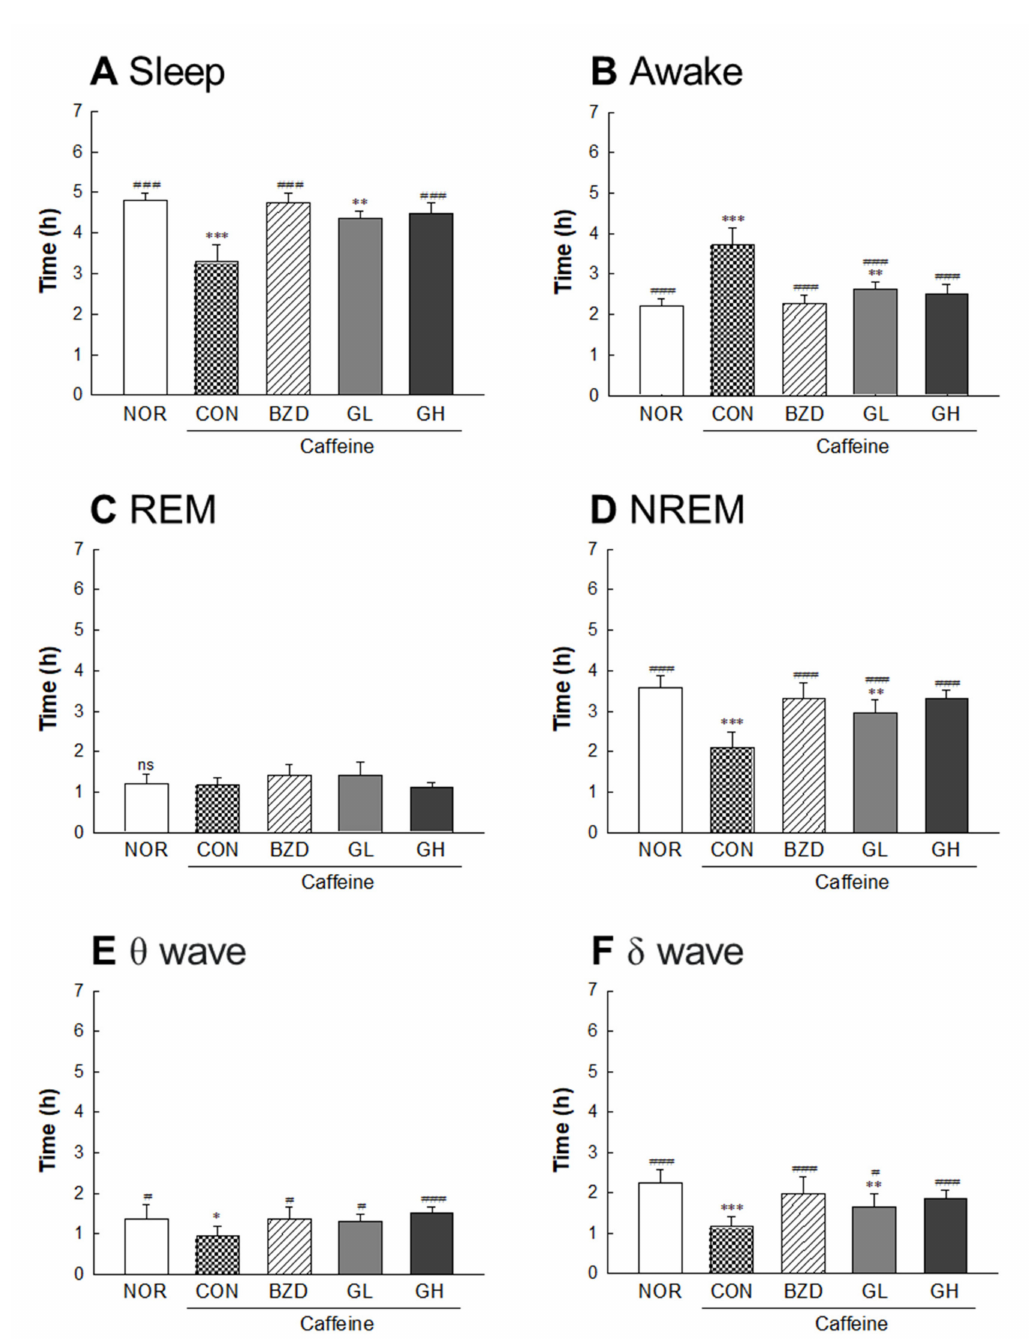
Figure 9. Effects of Lactobacillus -fermented γ -aminobutyric acid (LB-GABA) on electrophysiologic pattern in caffeine- induced wakefulness of rats. Caffeine (40 mg/kg) was administered as a stimulant for wakefulness before experiments. GABA was administered orally 1 h before electroencephalography (EEG) analyses, which were conducted for 3 days. ( A ) sleep time, ( B ) awake time, ( C ) duration of REM (rapid eye movement), ( D ) duration of NREM (non-rapid eye movement), ( E ) θ wave of NERM, and ( F ) δ wave of NREM.NOR: normal control (0.9% sodium chloride (NaCl)) group, CON: caffeine only treated (40 mg/kg) group, BZD: benzodiazepine (alprazolam, 300 µ g/kg)-treated group (positive control), GL and GH: low- and high-dose LB-GABA (100 and 200 mg/kg, respectively) with 40 mg/kg caffeine treatment. Values are means ± standard deviation (SD); * p < 0.05, ** p < 0.01, and *** p < 0.001 versus normal group; # p < 0.05, ## p < 0.01, and ### p < 0.001 versus caffeine group according to Tukey’s multiple comparison test; ns, not